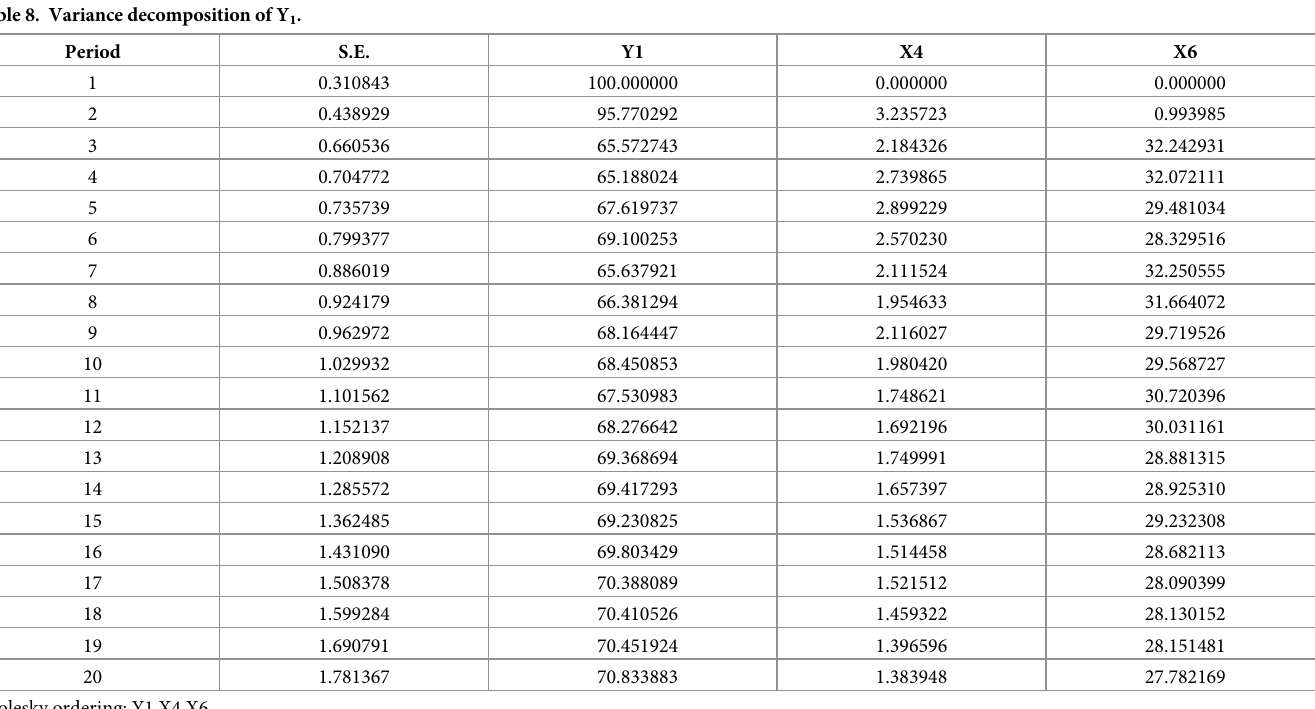
Table 8. Variance decomposition of Y 1 .